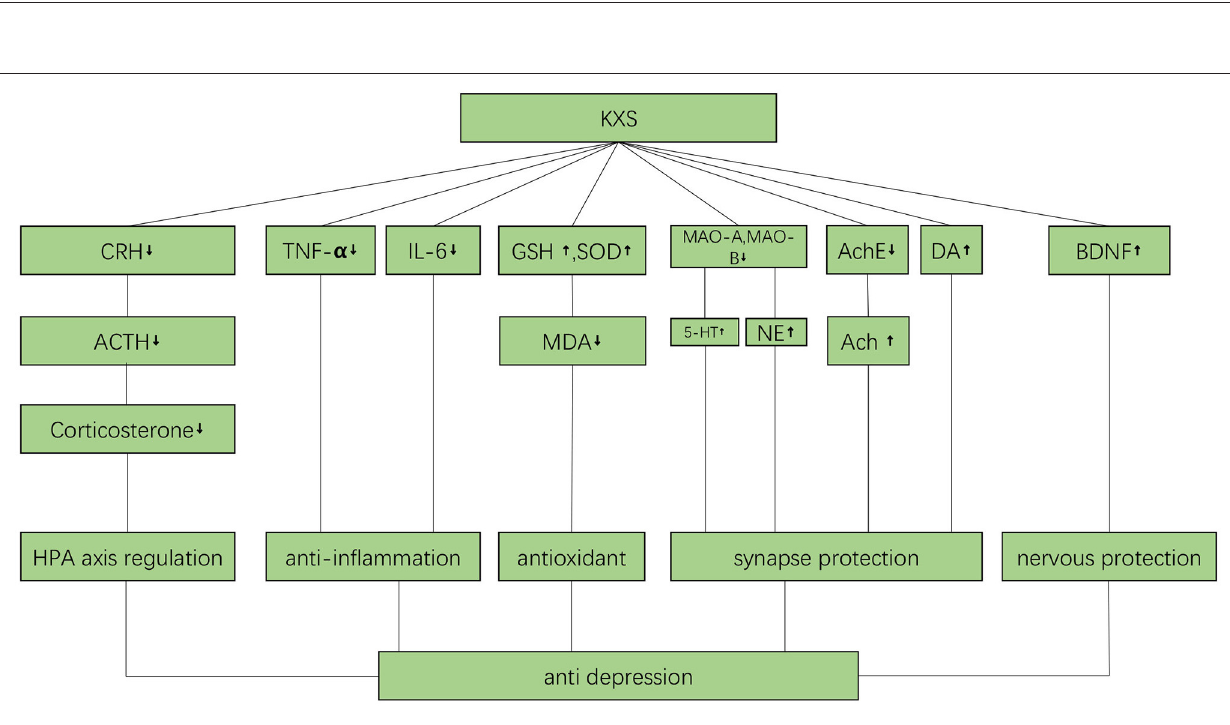
Frontiers in Neuroscience | www.frontiersin.org